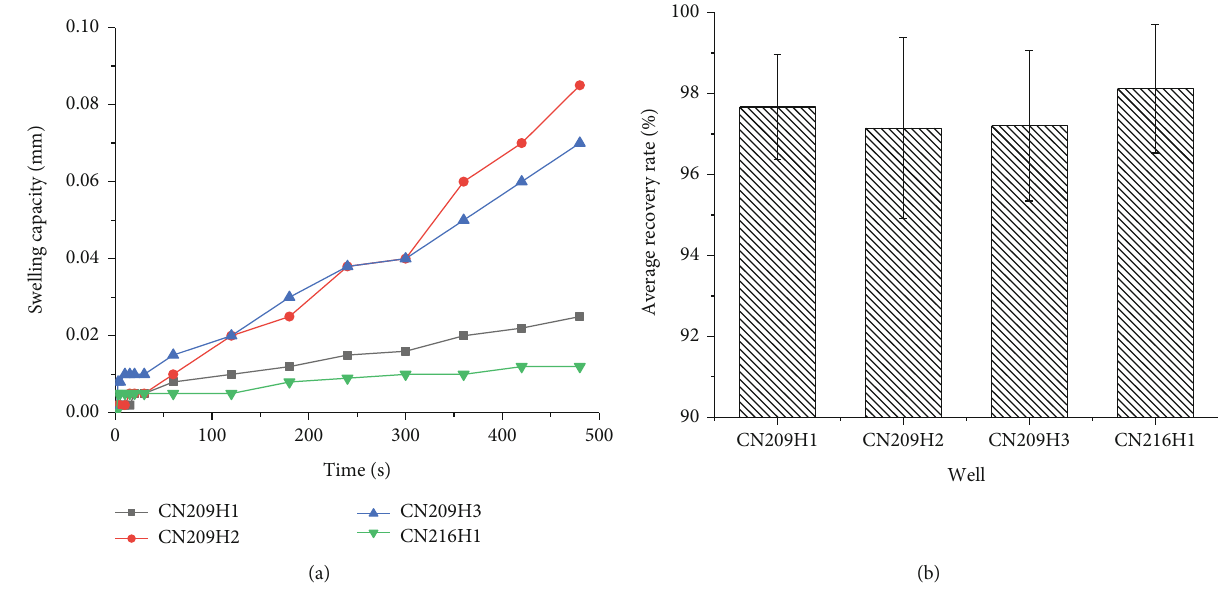
Figure 6: Drilling fl uid hydration expansion experiment. Table 2: Experimental evaluation results of drilling fl uid dispersion and slake durability. Rolling dispersion experiment of shale Sampled well number